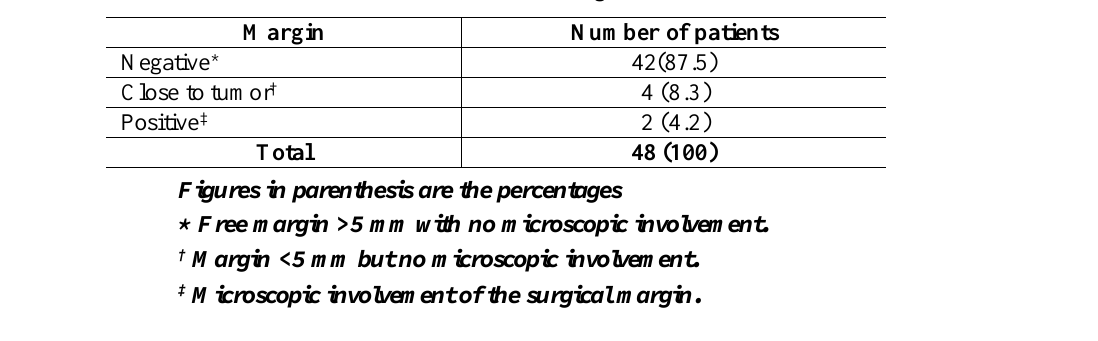
Table V : Status of the resected margins of the tumor